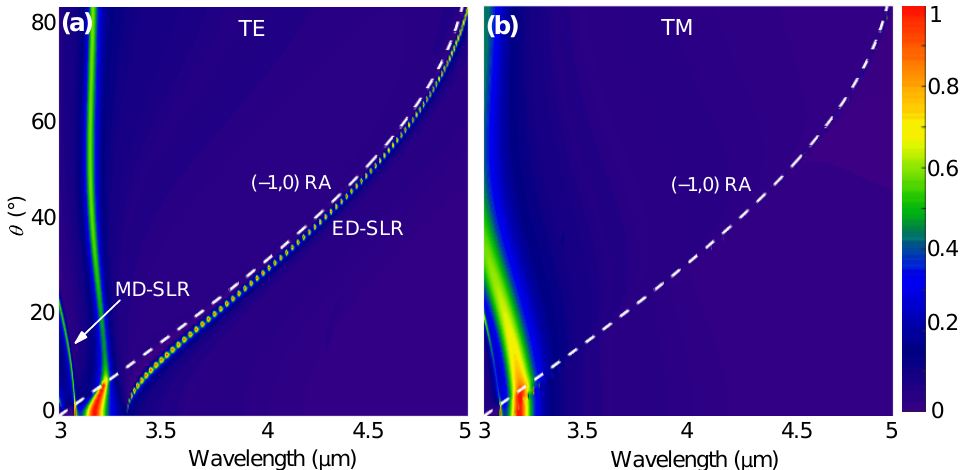
Figure 2. Calculated dispersion of the ED-SLR of the GST metasurface with m = 0. The reflectance spectra as a function of the incidence angle were simulated for ( a ) TE- and ( b ) TM-polarized incident light. White dashed curves represent the RA of the ( − 1,0 ) diffraction